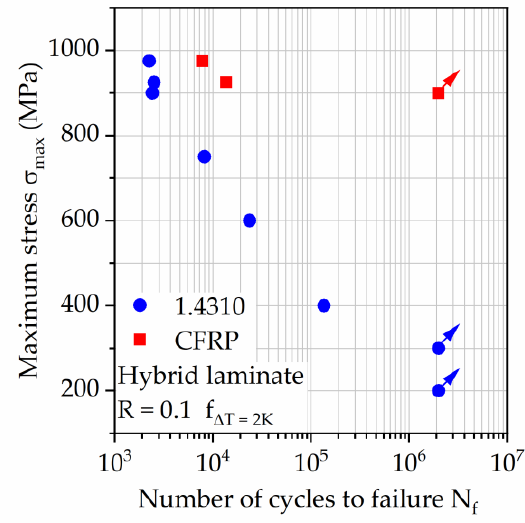
Figure 13. S–N relationship for hybrid laminate in 1/2-configuration of 1.4310 and carbon fiber reinforced PA 6. Failure for 1.4310 and postponed failure of carbon fiber reinforced PA 6 are marked. For tests with σ max below 900 MPa the tests were stopped after steel failure, since carbon fiber reinforced PA 6 proved to withstand 2 × 10 6 cycles at 900 MPa after failure of 1.4310.